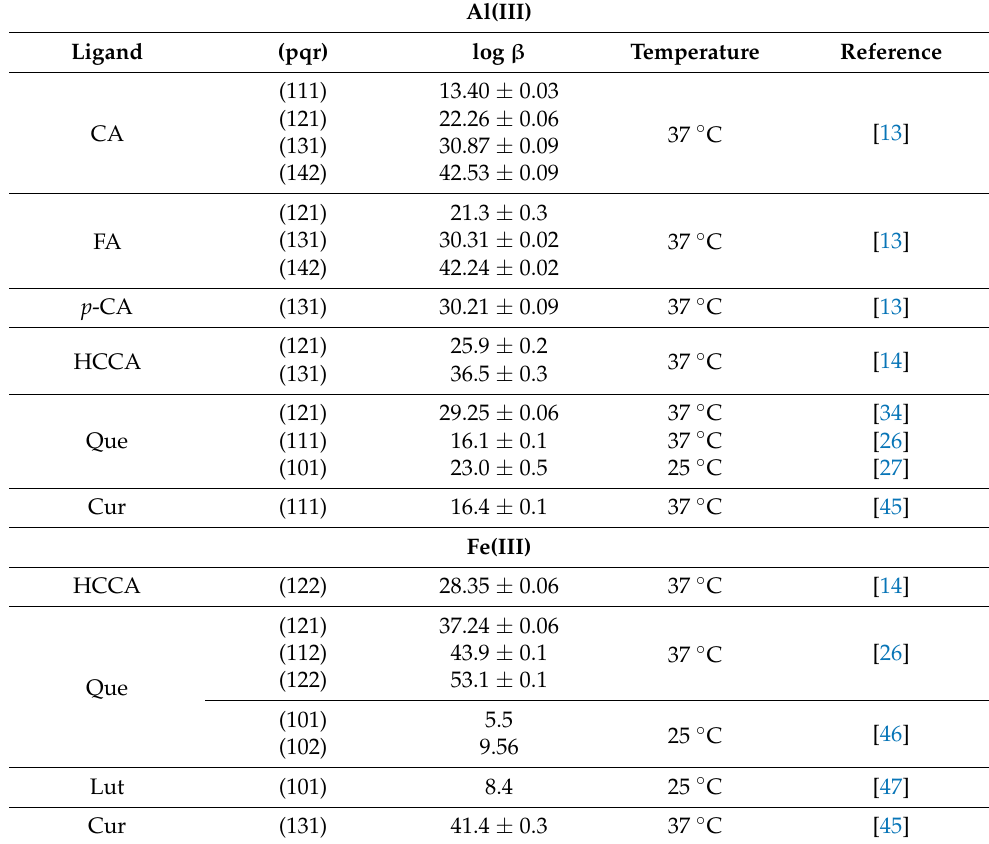
Table 1. Formation of complexes of some natural antioxidants with Al(III) and Fe(III), according to Equation (3). Standard deviations are reported as 3 σ